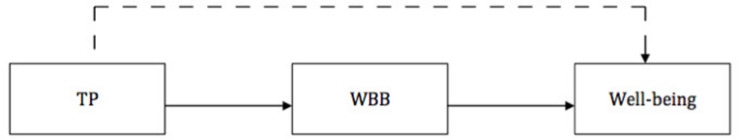
The trait-behavior model; TP, times perspective; WBB, well-being booster. Dashed line indicates that mechanisms other than given WBB may in parallel mediate the effect.